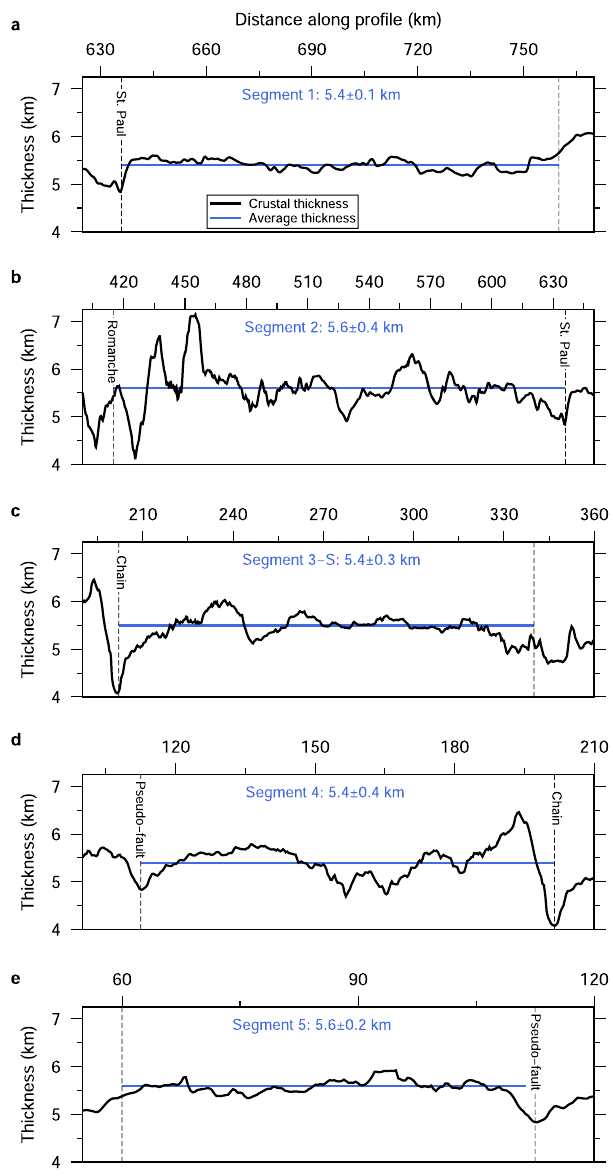
Fig. 5 | Crustal thickness. Crustal thickness variation (black curves) and average crustalthickness(bluelines)ofeachridgesegment.Thedashedlinesineachpanel indicate the boundaries of ridge segments. The segment numbers, the average crustal thickness, and the standard deviation are marked in